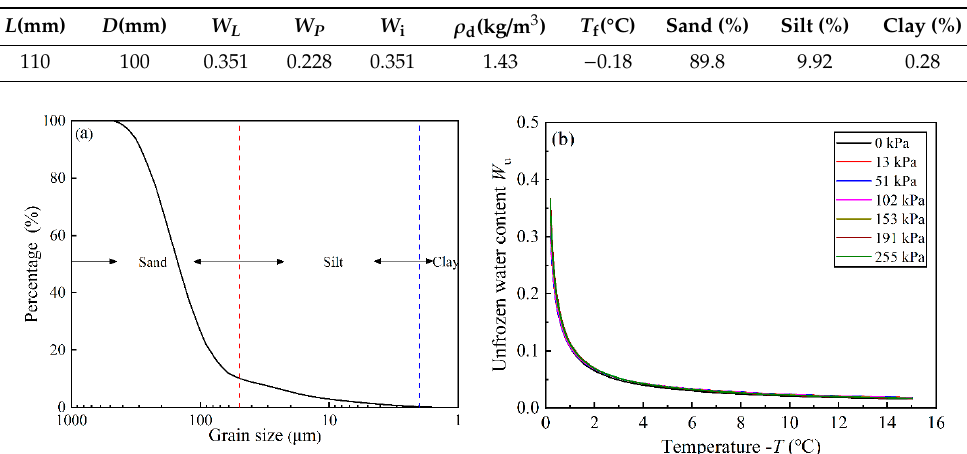
Table 1. Properties of the soil samples.